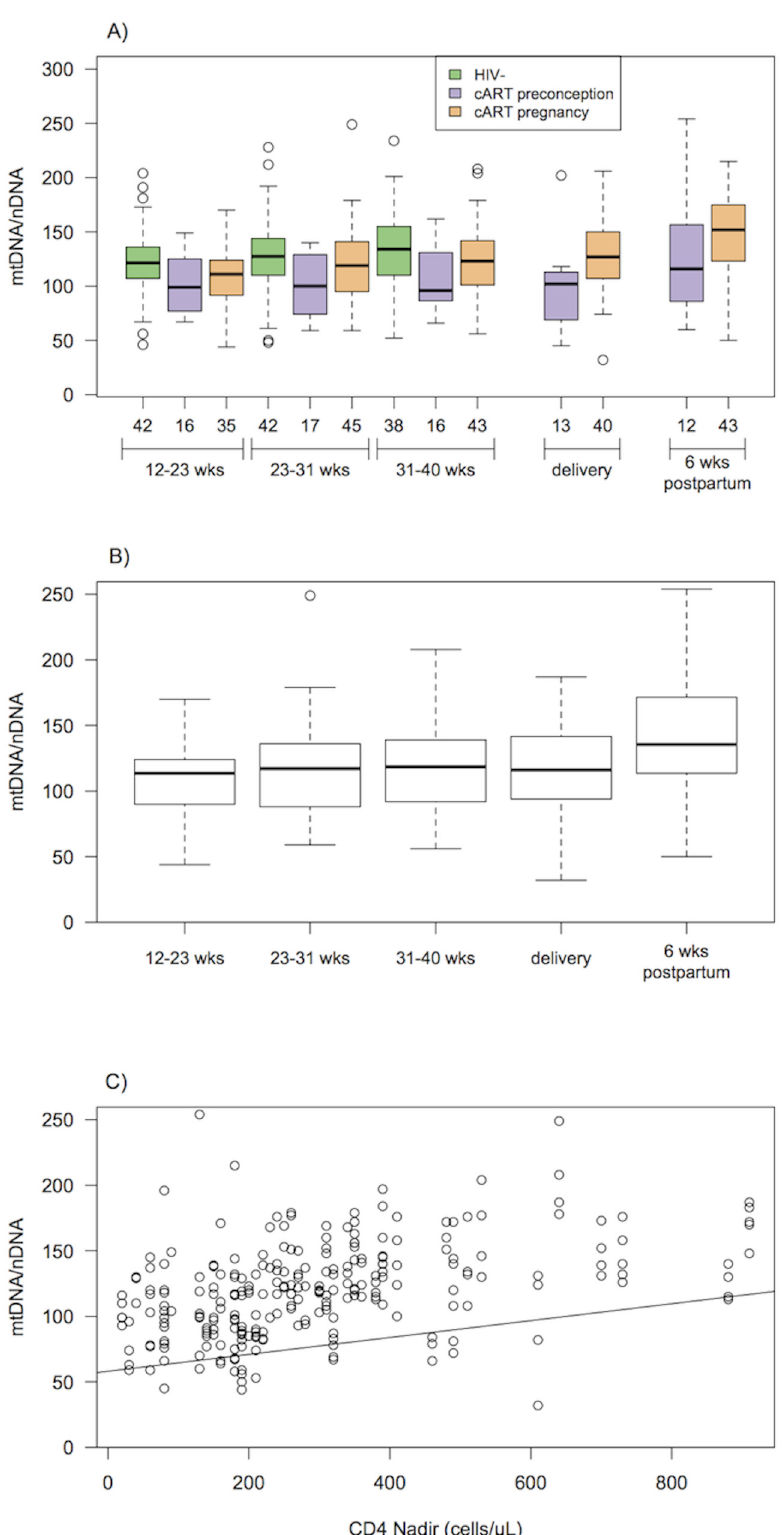
Fig 2. Temporal variation in mtDNA/nDNA ratio during pregnancy, at delivery and postpartum for the HIV+ cohort. A) mtDNA/nDNA ratio in HIV- women (n = 42), HIV+ women who initiated cART prior to